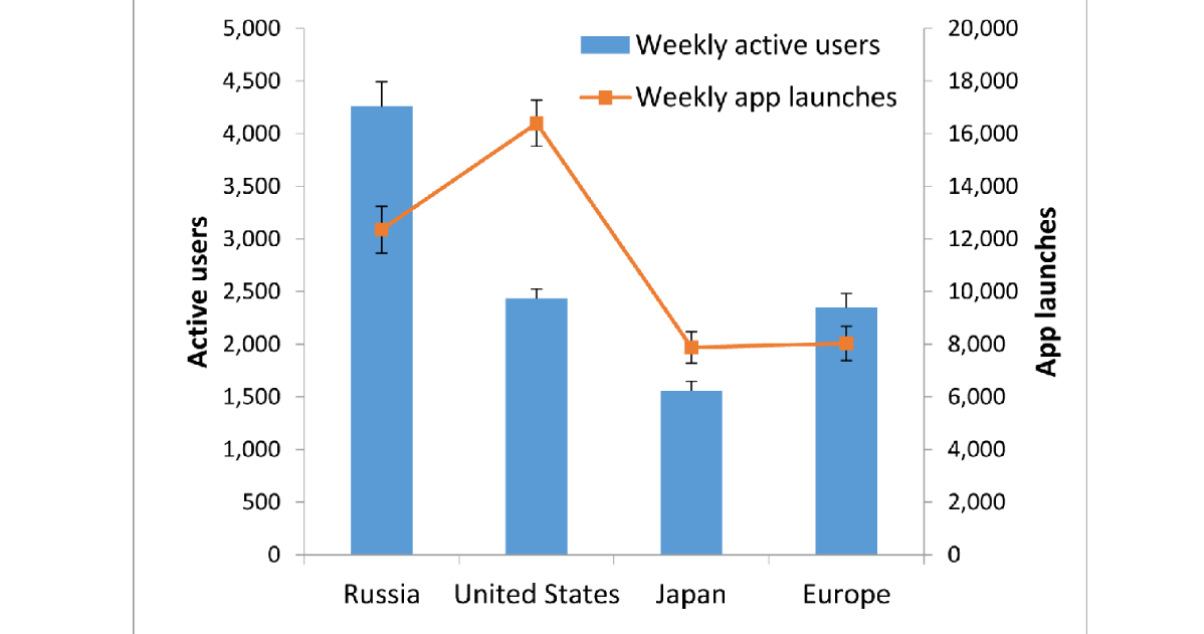
Figure 2. Four regions were included for separate analysis: Russia, the United States, Japan, and Europe. Their average numbers of weekly active users were 4259, 2436, 1558, and 2346, respectively. The corresponding average numbers of weekly app launches (number of times the app was used) were 12,353, 16,393, 7880 and 8031, respectively. Error bars indicate SD values.